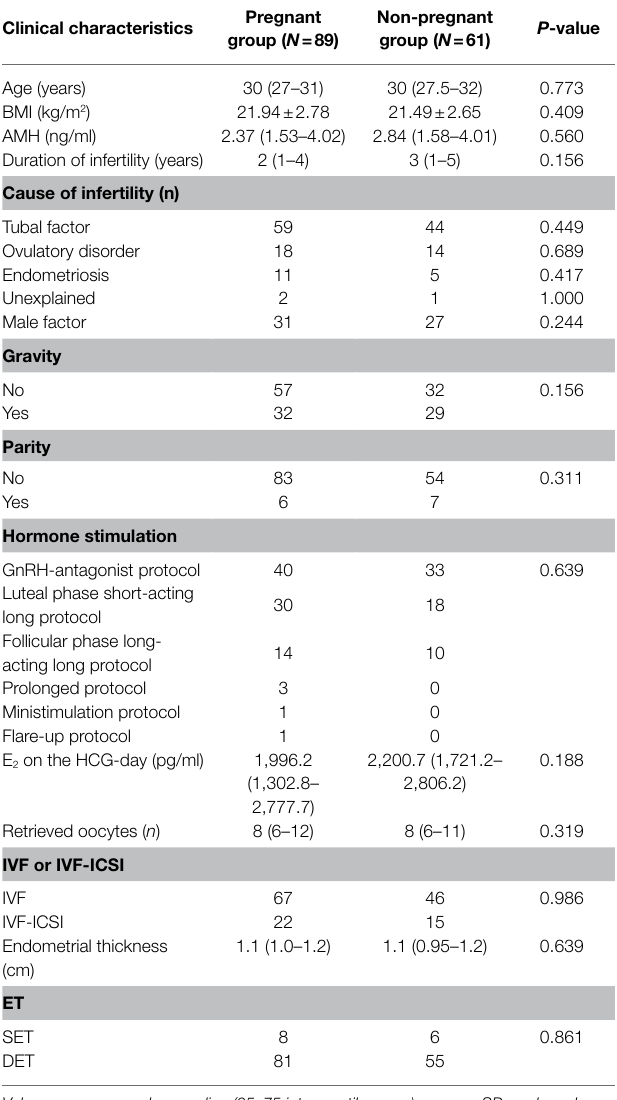
TABLE 1 | Clinical characteristics of the participants and comparisons between groups according to the achievement of clinical pregnancy. Clinical